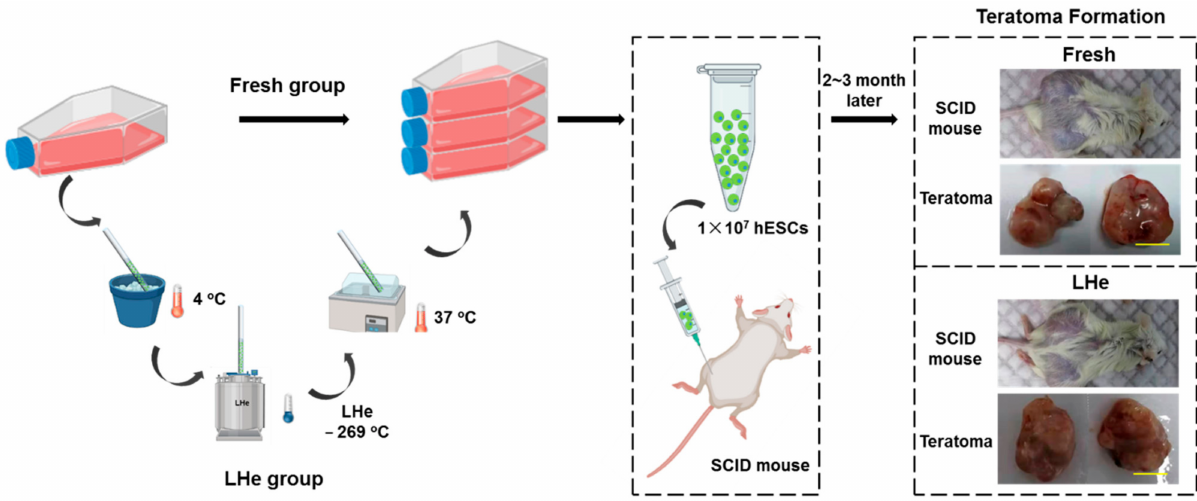
Figure 8. Schematic of teratoma formation for fresh and LHe-vitrified groups. Fresh or LHe-vitrified hESCs were cultured until the desired amount is achieved, then injected into SCID mice models. 2~3 months later, teratomas were fixed stained to confirm pluripotency of hESCs. Scale bar: 1